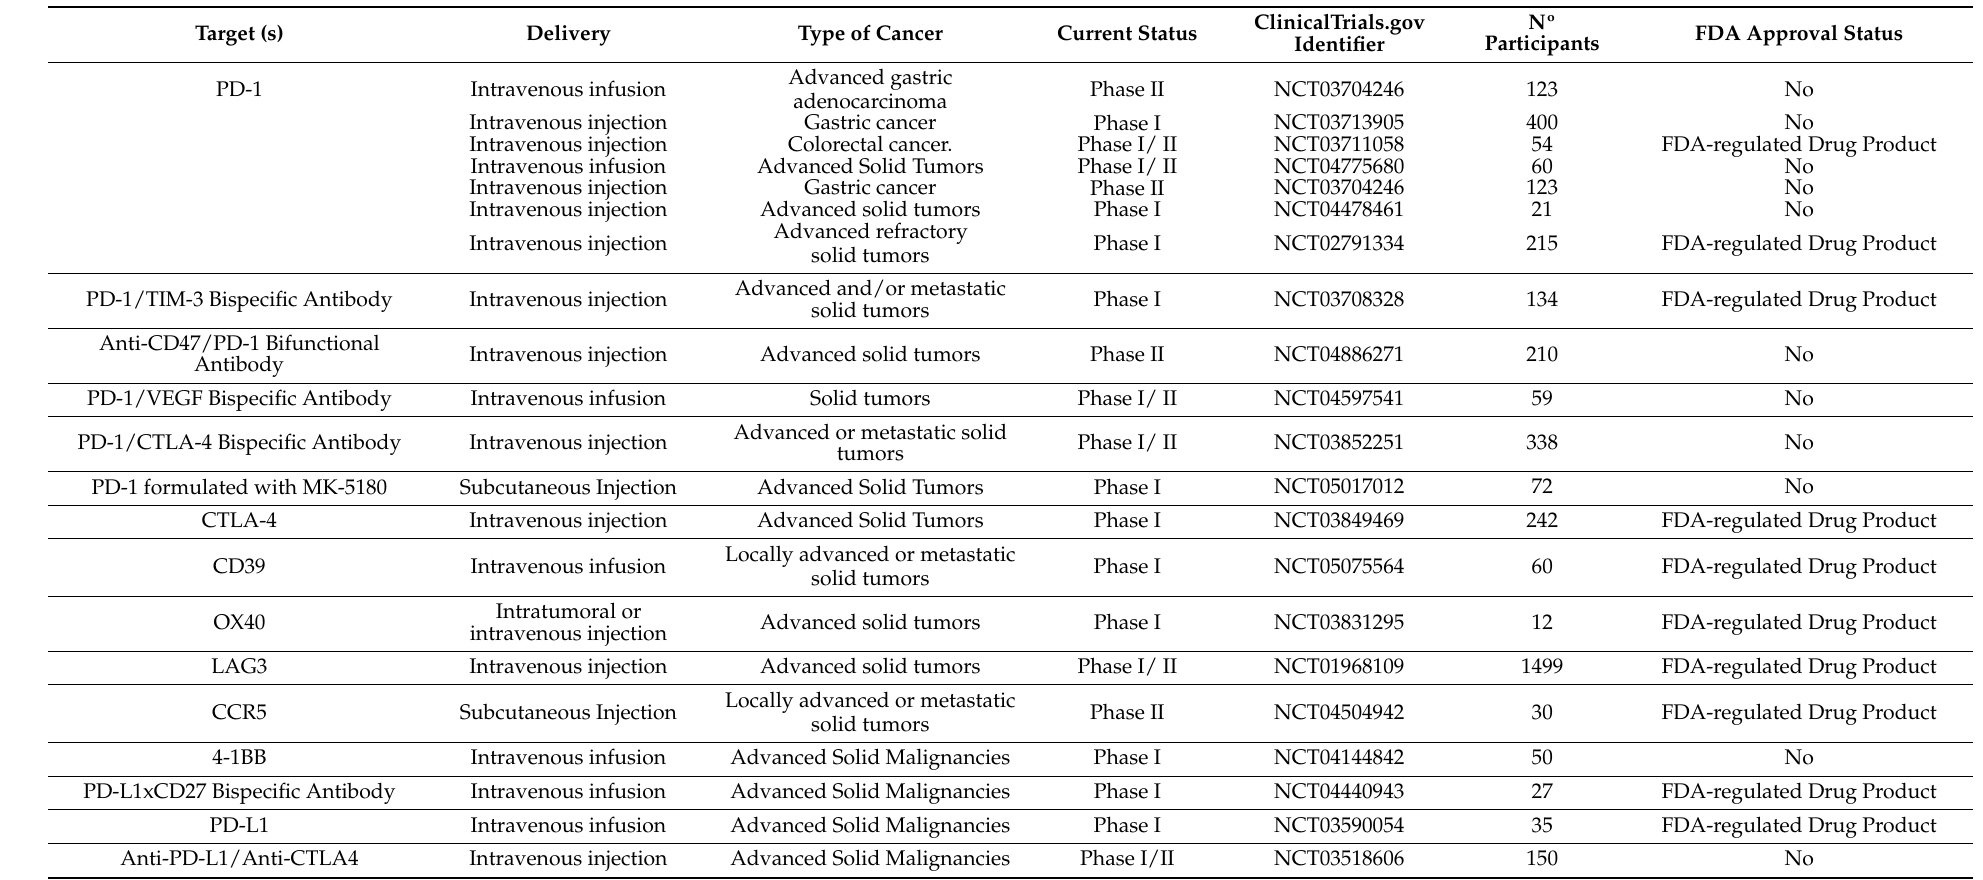
Table 2. Ongoing clinical trials of mAbs